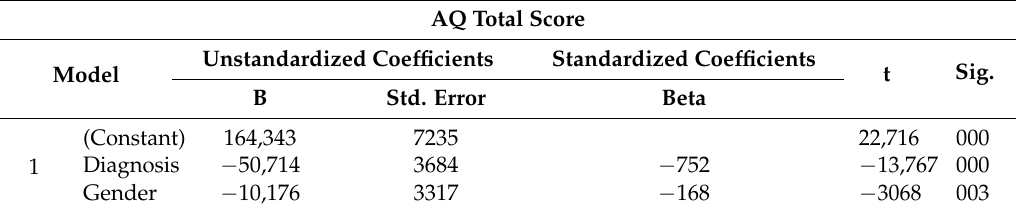
Table 3. Regression gender x